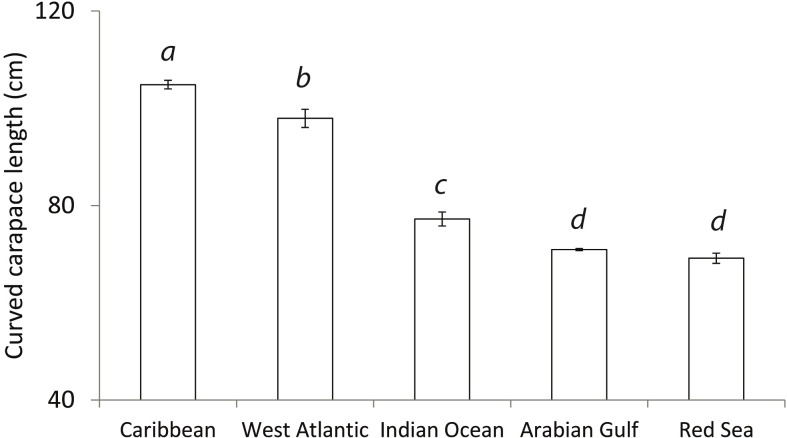
Comparison of CCL from different regions.Significant difference found between regions (ANOVA: F4,470: = 989.6; p<0.01). Data for the Arabian Gulf was from the present study, Pilcher et al. (2014) and Pazira et al. (2016); raw data from the Caribbean was collected from Xavier et al. (2006); Ross (1980) provided data from the Indian Ocean; Red Sea data was from Hirth and Abdel Latif (1980) and West Atlantic data was from Marcovaldi et al. (1999). Regions with significantly different CCL’s are represented by superscript letters above the bars.